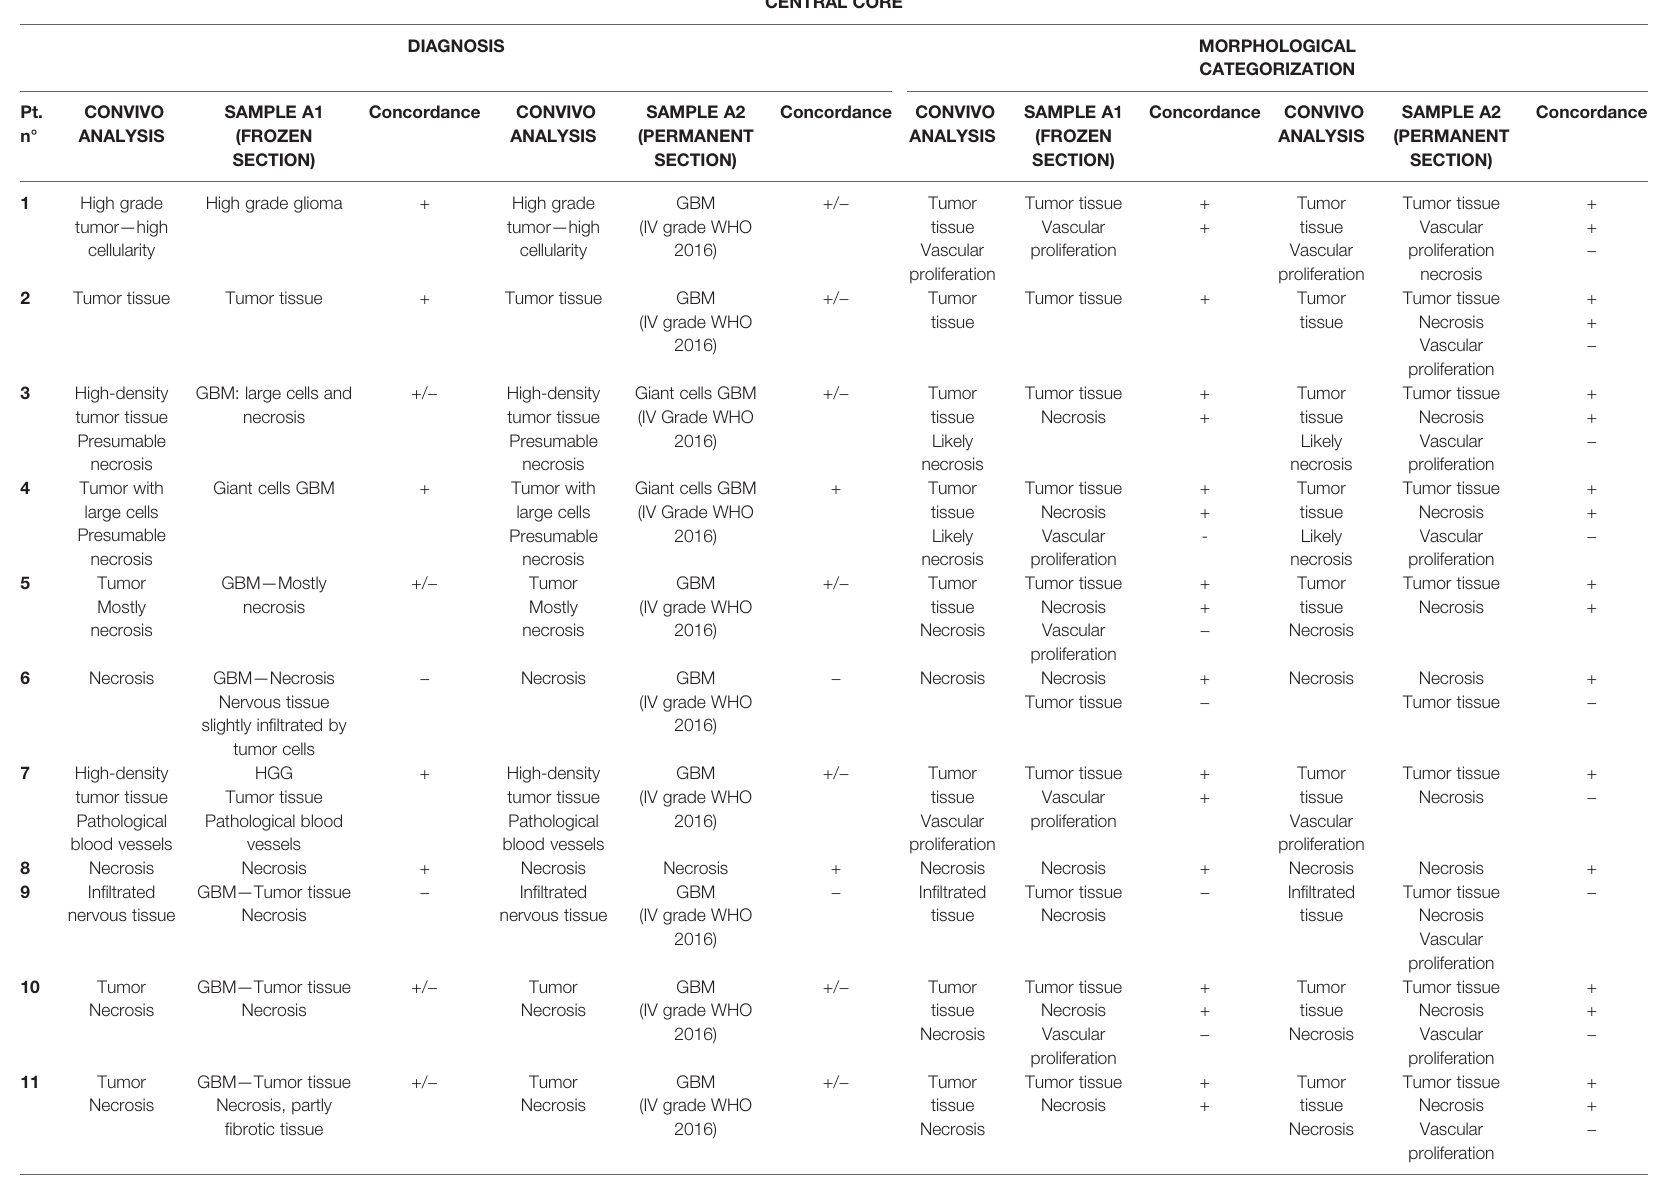
TABLE 1 | Comparison between CONVIVO ® , frozen section, and permanent section at central